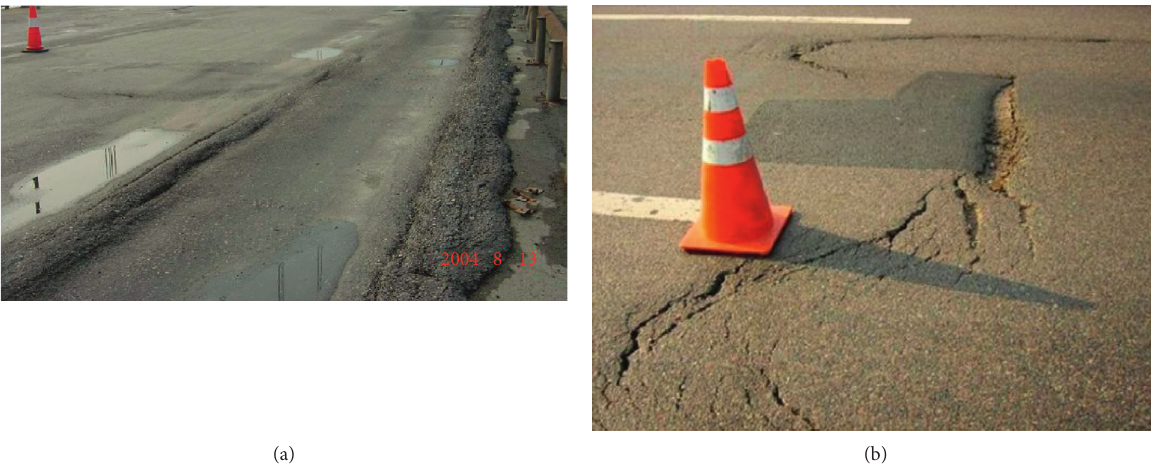
Figure 1: The damage of traditional asphalt pavement on a steel deck